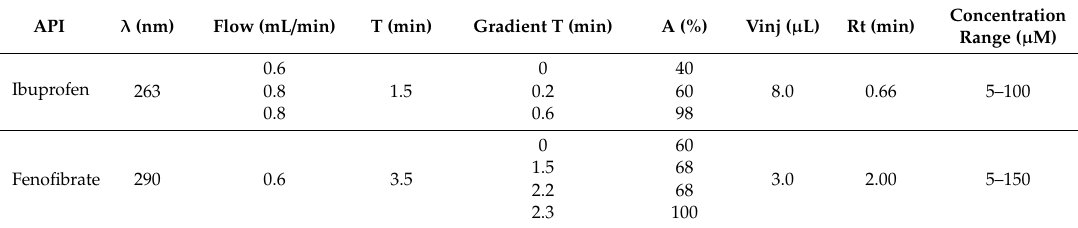
Table 2. HPLC methods used in the present